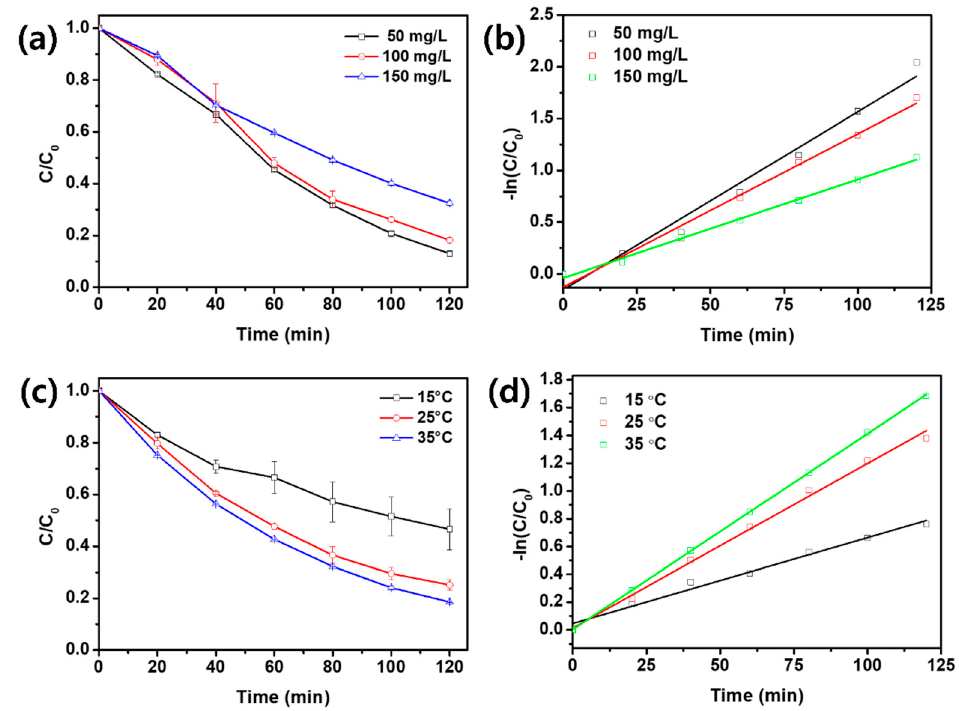
Figure 2. Effects of ( a ) initial concentration and ( c ) reaction temperature on OTC degradation. Pseudo-first-order kinetic plots for different ( b ) initial concentration and ( d ) reaction temperature conditions.